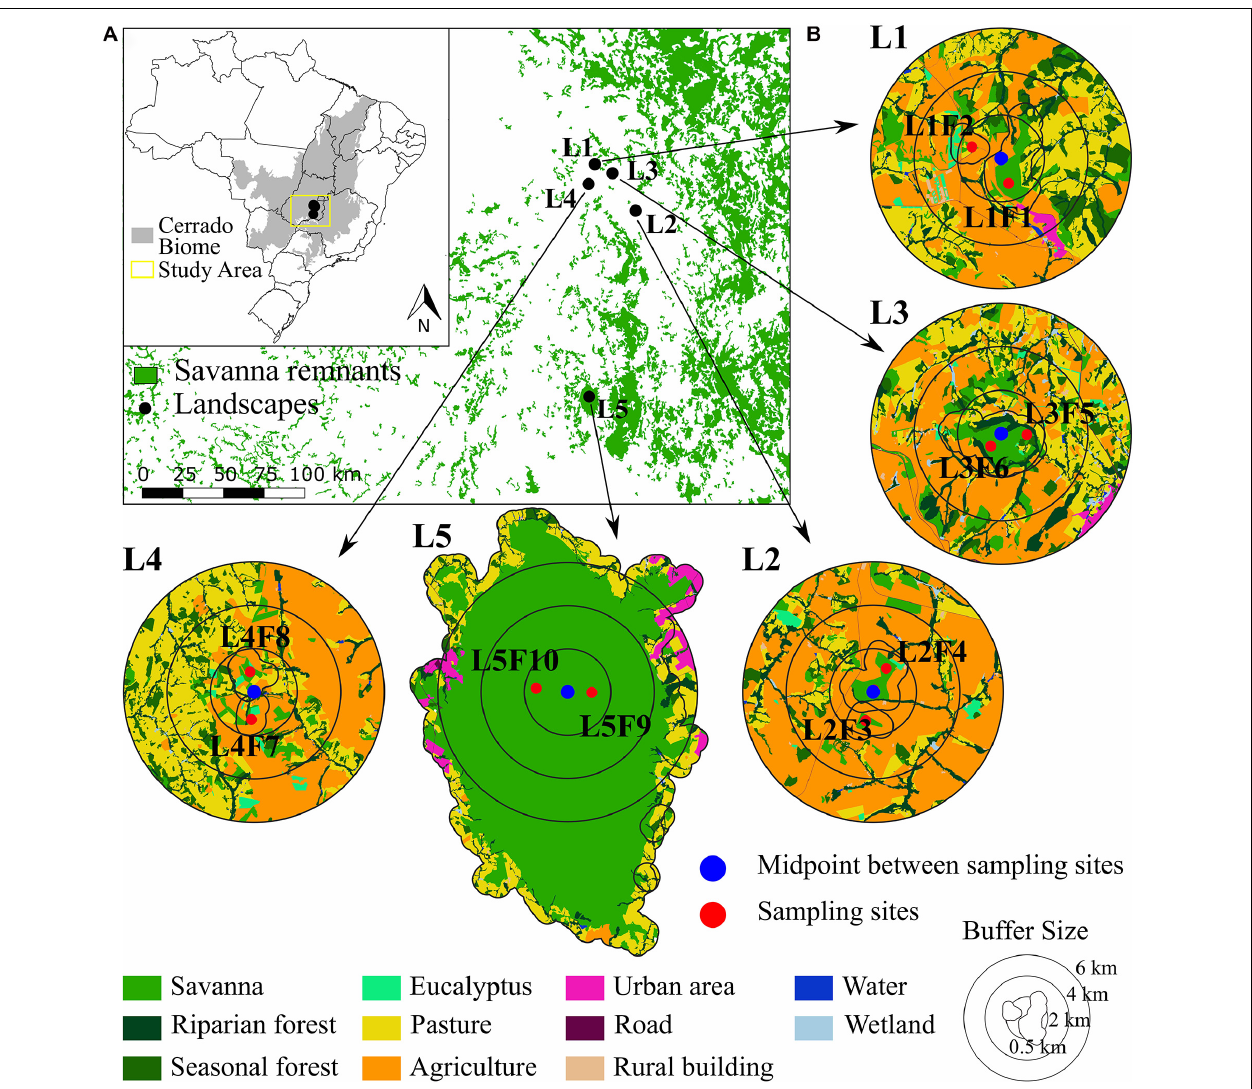
FIGURE 2 | Geographical distribution of the five landscapes and 10 sampling sites of Caryocar brasiliense in the Cerrado biome. (A) The distribution of the Cerrado biome in Brazil (gray) and the five landscapes. (B) The five landscapes and sampling sites (red dots). The multi-scale landscapes are represented by buffers of 2, 4, and 6 km created around the midpoint (blue triangle) between the two sites within each landscape. Inner polygons around sampling sites are the 0.5 km buffers for node analyses. Land use categories are in